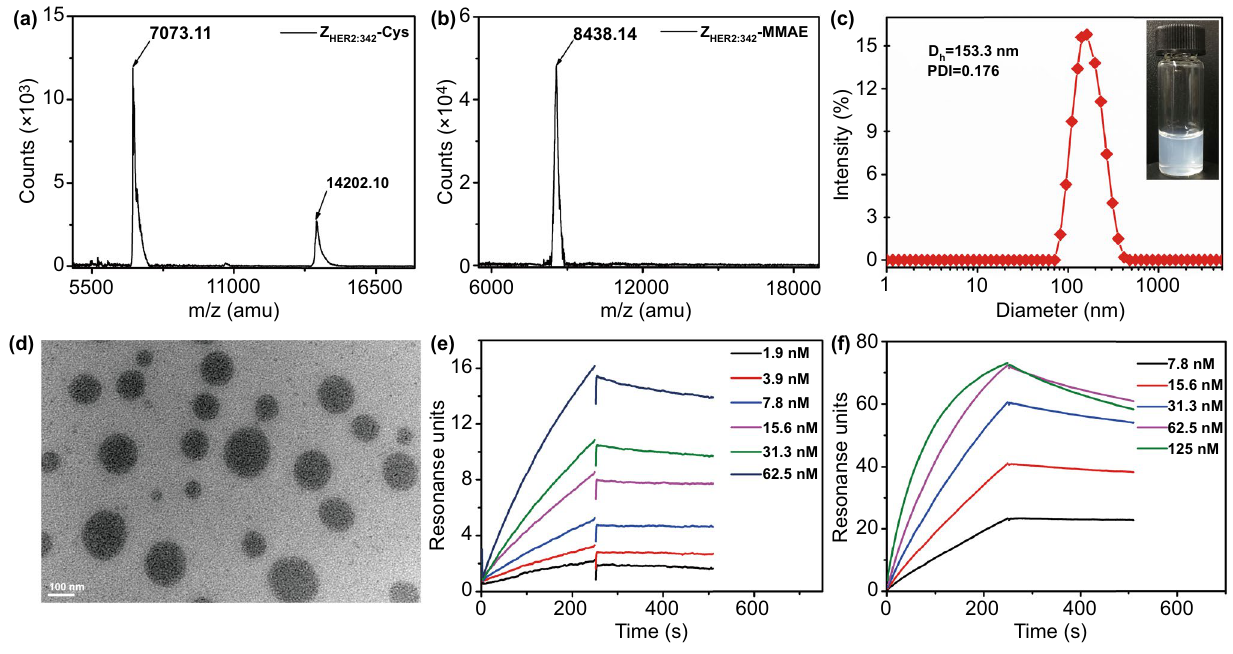
Fig. 2 Characterizations of Z HER2:342 -Cys and Z-M ADCN. a MALDI-TOF spectrometry of Z HER2:342 -Cys. b MALDI-TOF spectrometry of Z HER2:342 -MMAE conjugate. c DLS curve of Z-M ADCN. Inset: a digital photograph of Z-M ADCN solution, exhibiting a homogeneous bluish solution. d TEM image of Z-M ADCN. Scale bars: 100 nm. e Biacore analysis of the affinity between Z HER2:342 -Cys and extracellular domain (ECD) of HER2. f Biacore analysis of the affinity between Z-M ADCN and ECD of